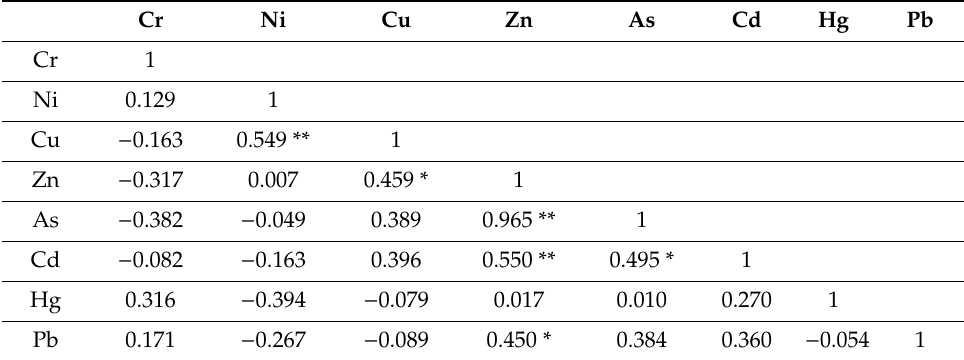
Table 6. Correlation matrix showing the correlation coe ffi cients between the investigated trace